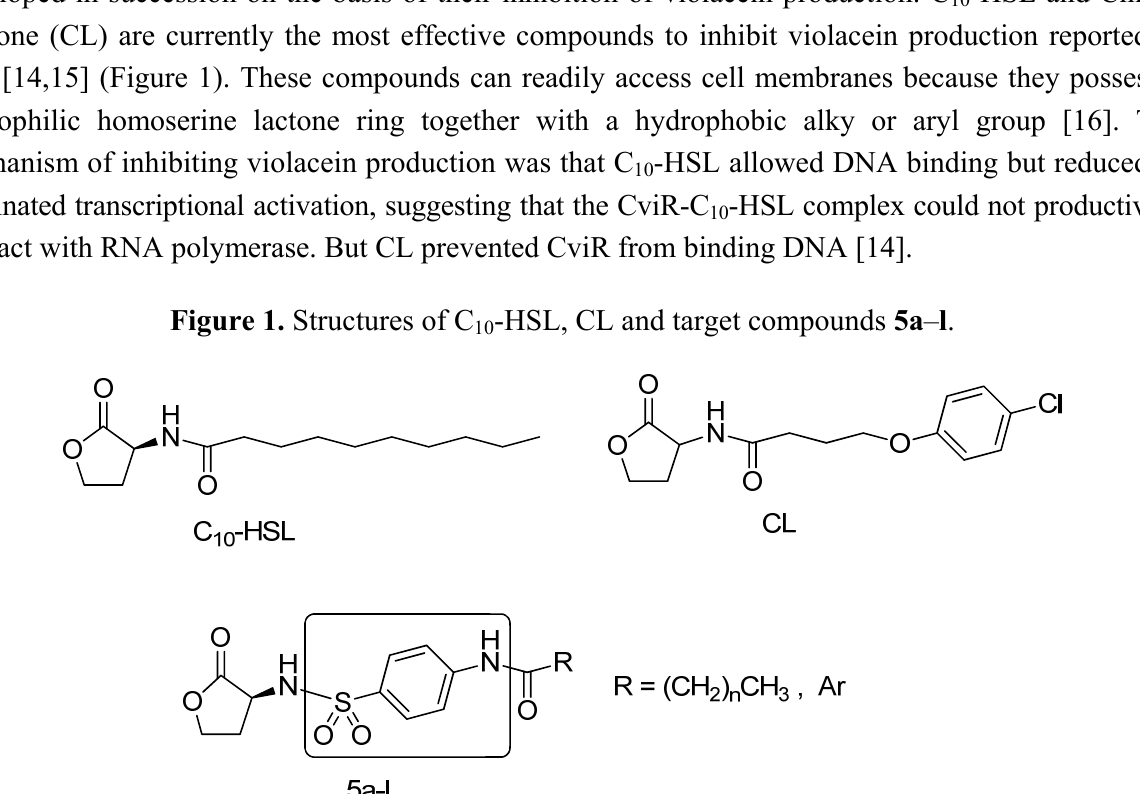
Figure 1. Structures of C